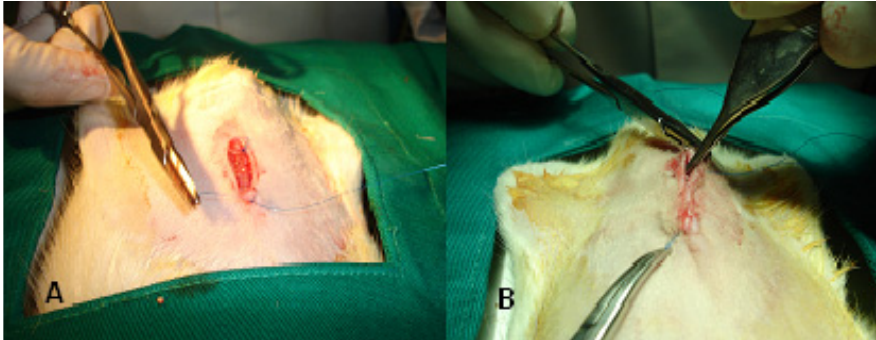
FIGURE 1 - Synthesis of the abdominal wall with continuous suture of the aponeurotic muscle with 6-0 polypropylene suture ( A ) and using the Greek technique with the same type of suture ( B